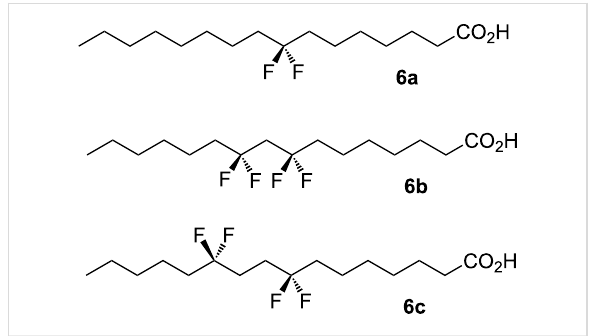
Figure 3: Synthesis targets: Palmitic acid analogues 6a–c .